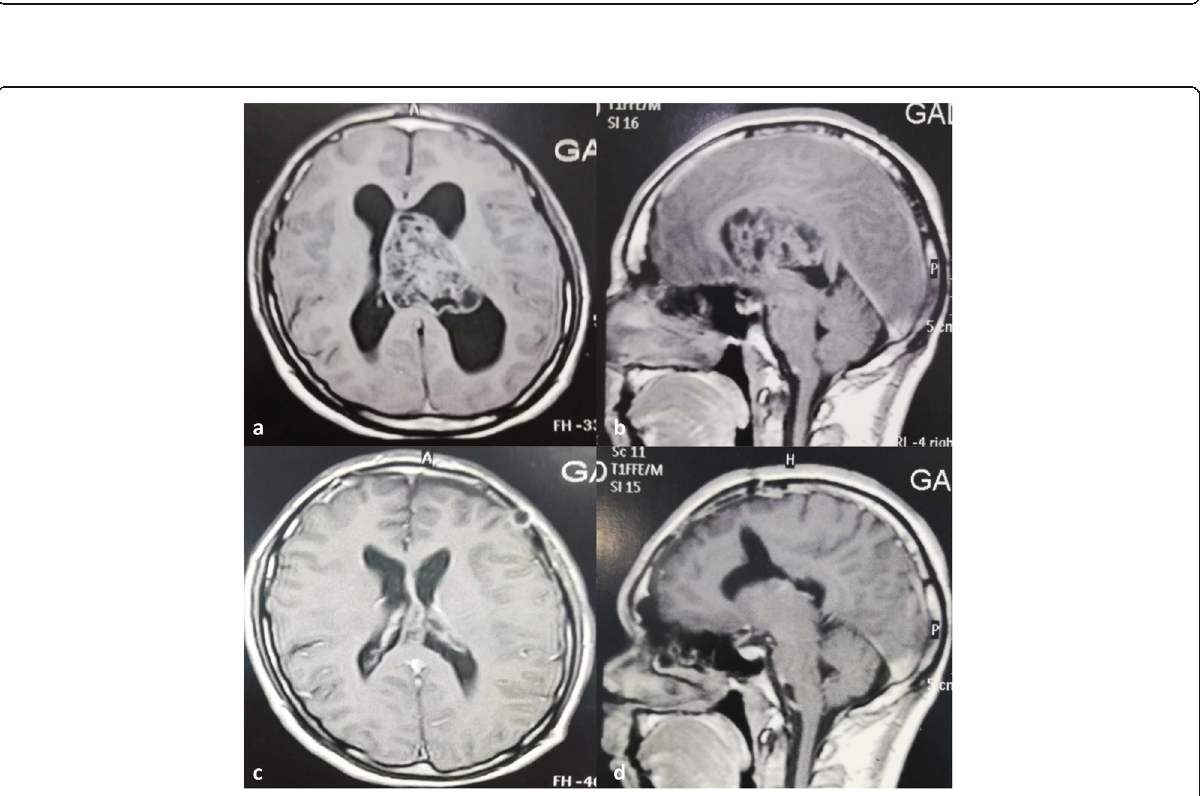
Fig. 4 A large intraventricular central neurocytoma in a 25-year-old male patient. a , b The preoperative axial and sagittal contrast-enhanced brain MRI study. c , d The postoperative axial and sagittal contrast-enhanced brain MRI study. Total excision of tumor was achieved following left frontal trans-cortical approach through the left middle frontal